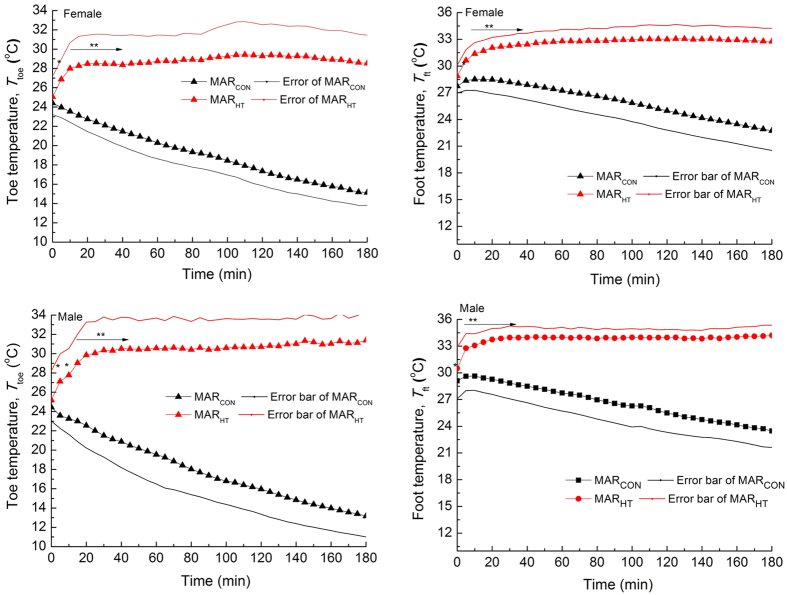
The evolution curves of the 4th toe and the left foot temperatures for females and males in MARCON and MARHT.